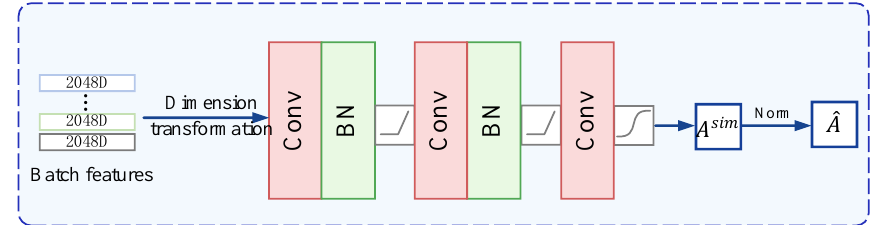
Figure 2. The architecture of the SGSL model. Input batch sample features X b . After dimension transformation, the initial representations of structural correlations can be obtained. Then after the convolutional layer, batch normalization, and activation function, the correlation between batch sample features is